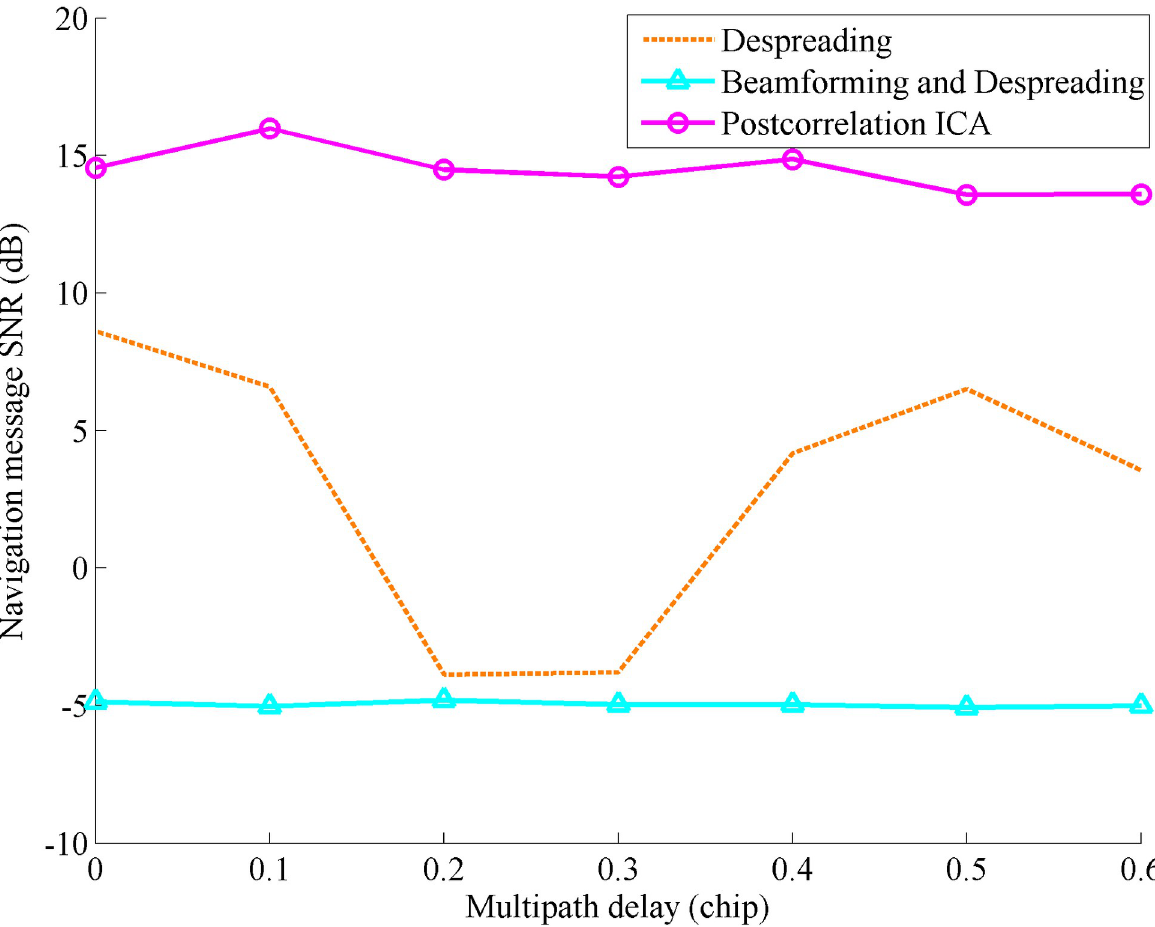
Fig 5. SNR comparison of the navigation message with the multipath delay changing after despreading, beamforming and despreading, and postcorrelation ICA processing.